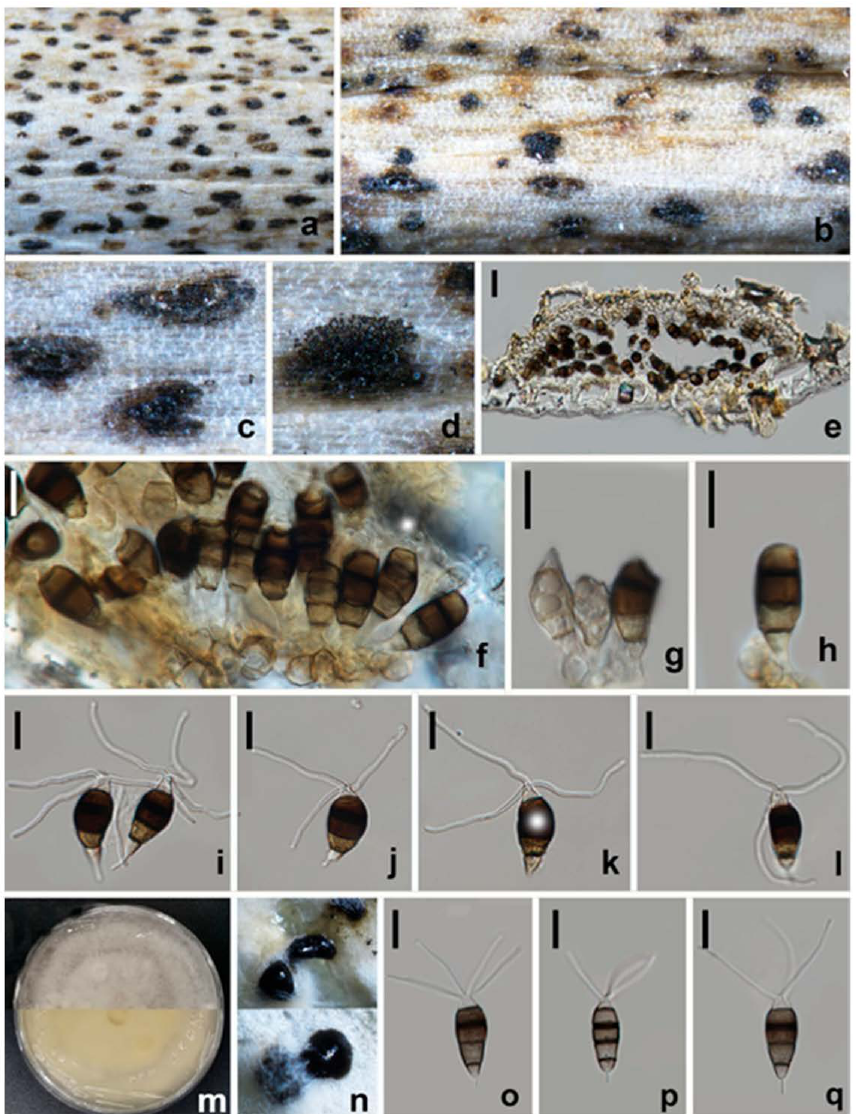
Figure 7. Neopestalotiopsis paeonia-suffruticosa (HKAS 123212, holotype) ( a – d ) Appearance of conid- iomata on the host. ( e ) Vertical section of conidioma. ( f ) Sporodochium. ( g , h ) Conidiogenous cells and conidia. ( i – l , o – q ) Conidia. ( m ) Upper and reverse view of colony on PDA. ( n ) Appearance of conidia mass on PDA. Scale bars: ( e ) = 20 µ m, ( f – l , o – q ) = 10 µ m. Culture characteristics: Colonies on PDA reaching 70 mm diam. after 7 d at 25 ◦